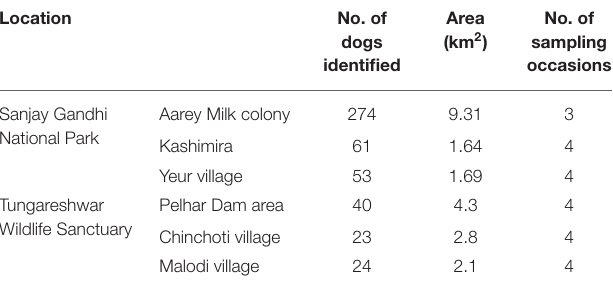
TABLE 4 | Summary of photo-captures of domestic dogs in three locations in Sanjay Gandhi National Park and Tungareshwar Wildlife Sanctuary in 2015 and 2016,